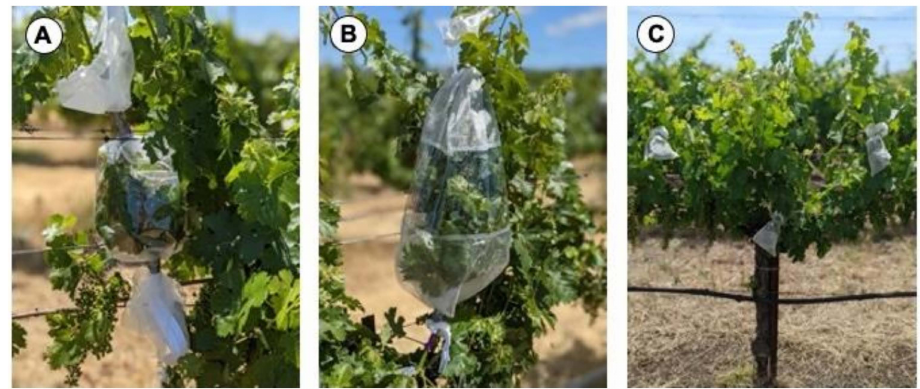
Figure 1. Distinct sleeve configurations used in transmission assays of grapevine red blotch virus by Spissistilus festinus in a ‘Cabernet Sauvignon’ vineyard. ( A ) A peppermint candy sleeve configuration allowing for cohorts of 10 S. festinus to feed on a restricted area of a shoot, ( B ) A tootsie roll sleeve configuration in which cohorts of 20 S. festinus were confined to an entire shoot, and ( C ) A lollipop sleeve configuration in which two S. festinus were allowed to feed on a single leaf on a middle– middle–bottom arrangement. Other lollipop sleeve configurations included middle–middle–top, top–middle–bottom, and